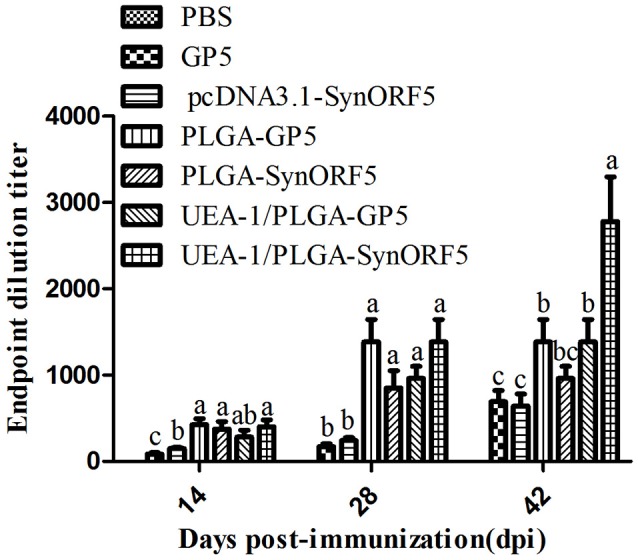
Systemic immune response in mice induced by different PRRSV vaccine formulations. Female BALB/c mice (6–8 weeks old, n = 7 in each group) were orally immunized with 100 μL of PBS, pcDNA3.1-SynORF5, GP5, PLGA-SynORF5, PLGA-GP5, UEA-1/PLGA-SynORF5, or UEA-1/PLGA-GP at 0 and 2 weeks. Sera were collected at 14, 28, and 42 dpi to determine GP5-specific IgG antibody by ELISA. Data represent the mean and s.e.m. of 7 mice per group. Columns with different letters differ significantly (P < 0.05).